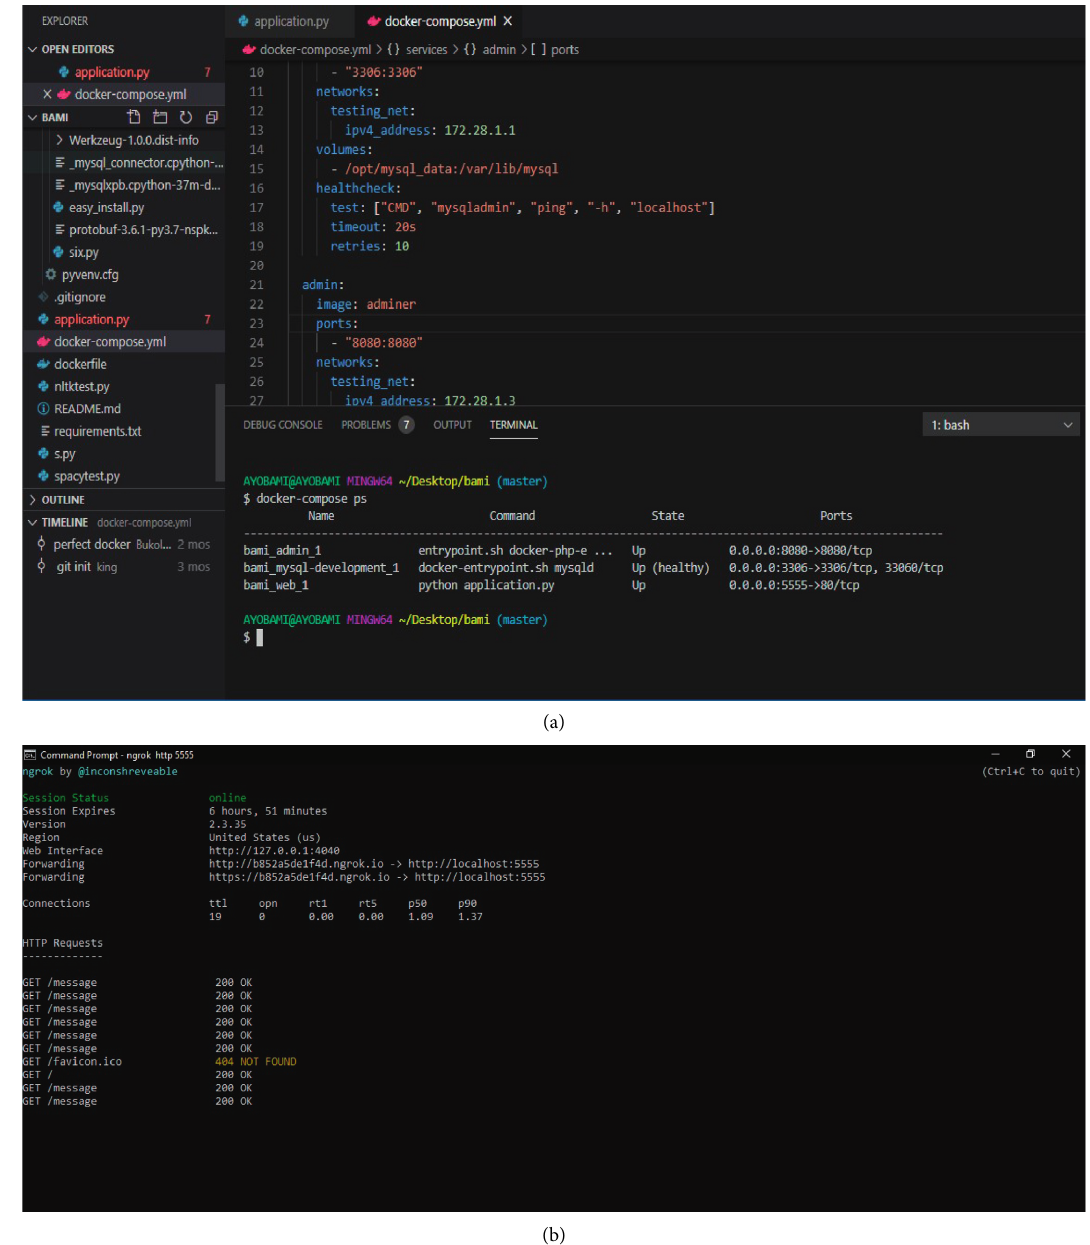
Figure 8: (a) Backend testing and result. (b) Backend testing and